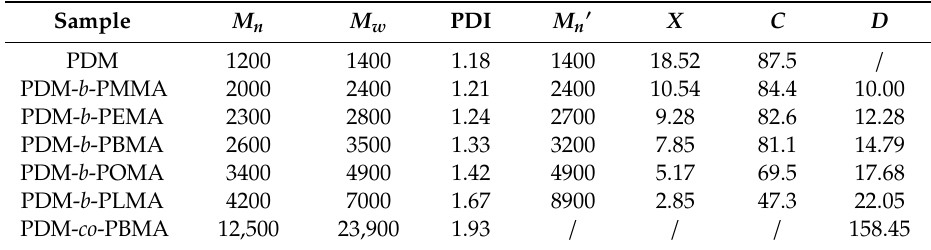
Table 2. E ff ect of HSC length on the molecular weight and double bond content of PDM- b